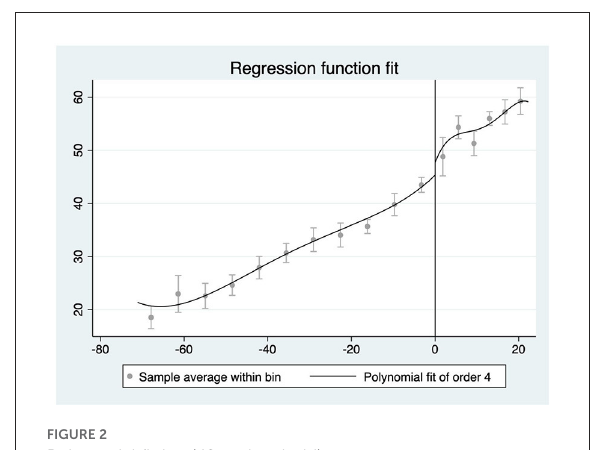
FIGURE2 Polynomial fitting (40 as